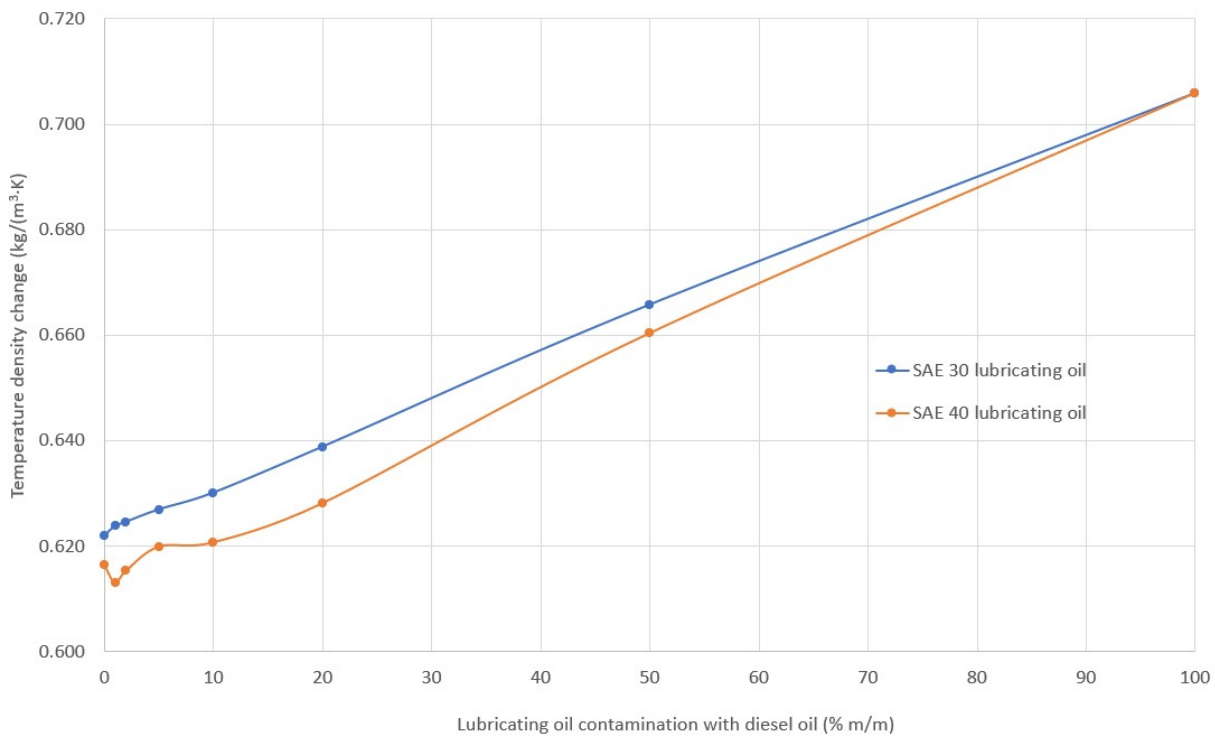
Figure 13. Calculated values of the coefficient of temperature change in density of the lubricating oils tested at different levels of lubricating oil dilution with diesel fuel. The measured kinematic viscosity values of lubricating oil–diesel blends for different concentrations in the temperature range of 40–100 °C for SAE 30 and SAE 40 grade oils are shown in Figures 14 and 15, respectively. Their viscosity decreases with increasing temperature. Increasing the diesel content in the lubricating oil mixture results in a de- crease in kinematic viscosity at a given temperature.